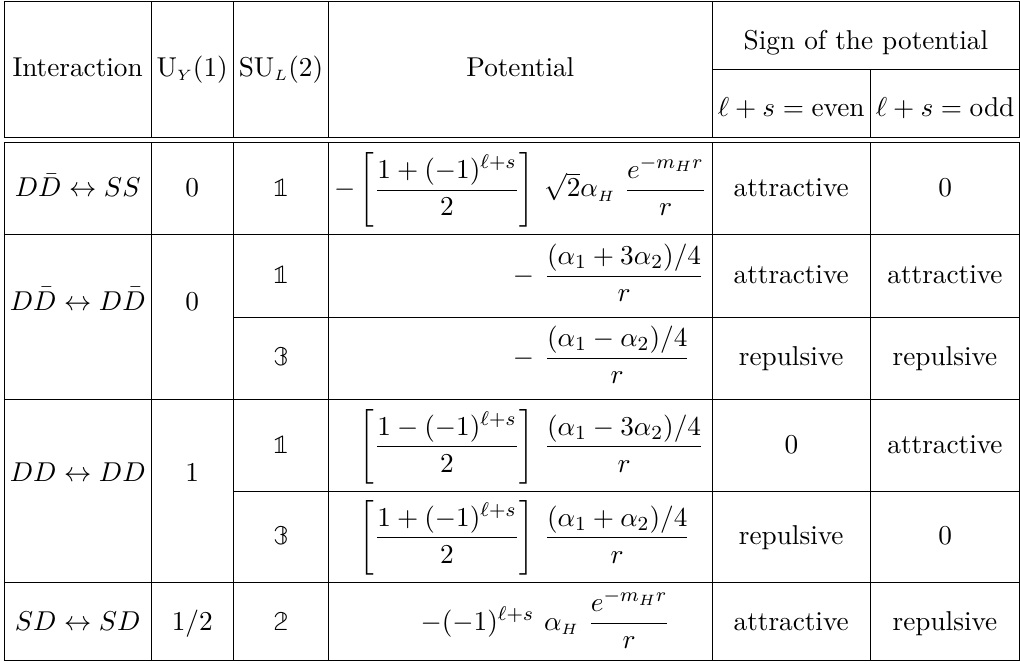
Table 2 . The static potentials generated by the W , B and H -exchange diagrams shown in figure 1. ‘ and s denote the orbital angular momentum mode and the total spin